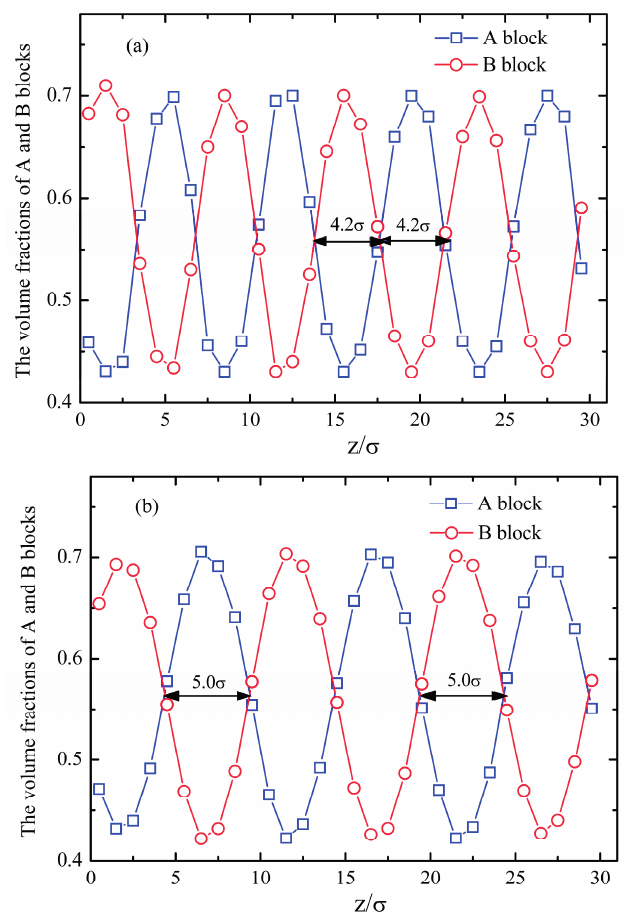
Figure 4. Variations of the volume fractions of blocks A and B along the z -direction